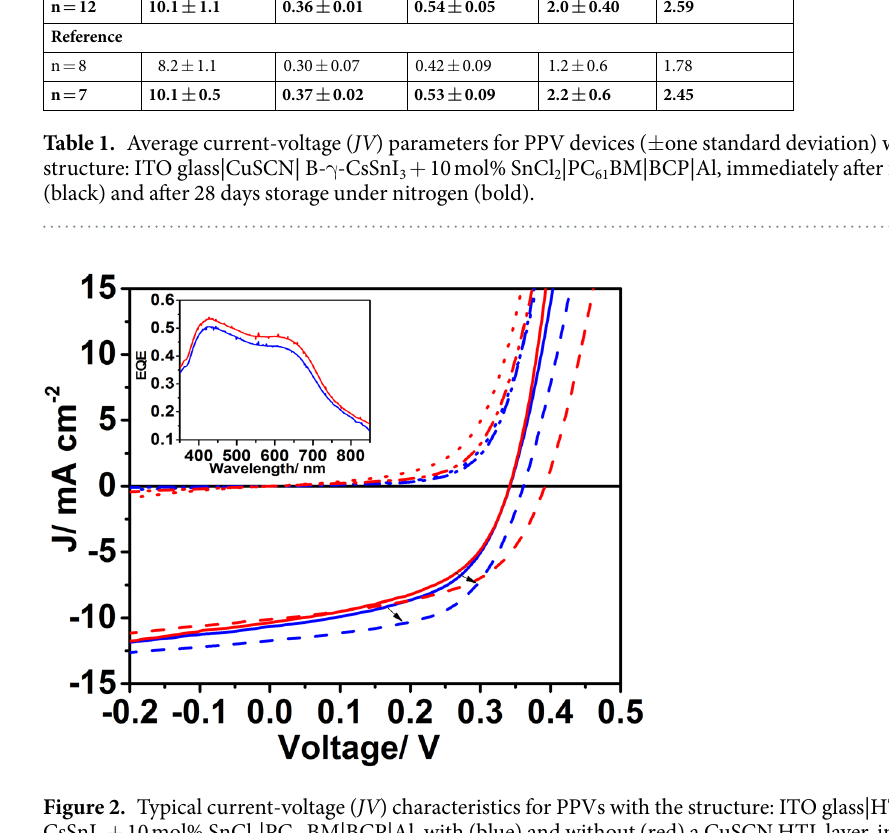
Figure 2. Typical current-voltage ( JV ) characteristics for PPVs with the structure: ITO glass|HTL| B- γ - efficiency (EQE) spectra for devices with (blue) and without (red) a CuSCN HTL. All device fabrication and testing was performed in a nitrogen filled glovebox ( < 1 ppm H 2 O and O 2 ).